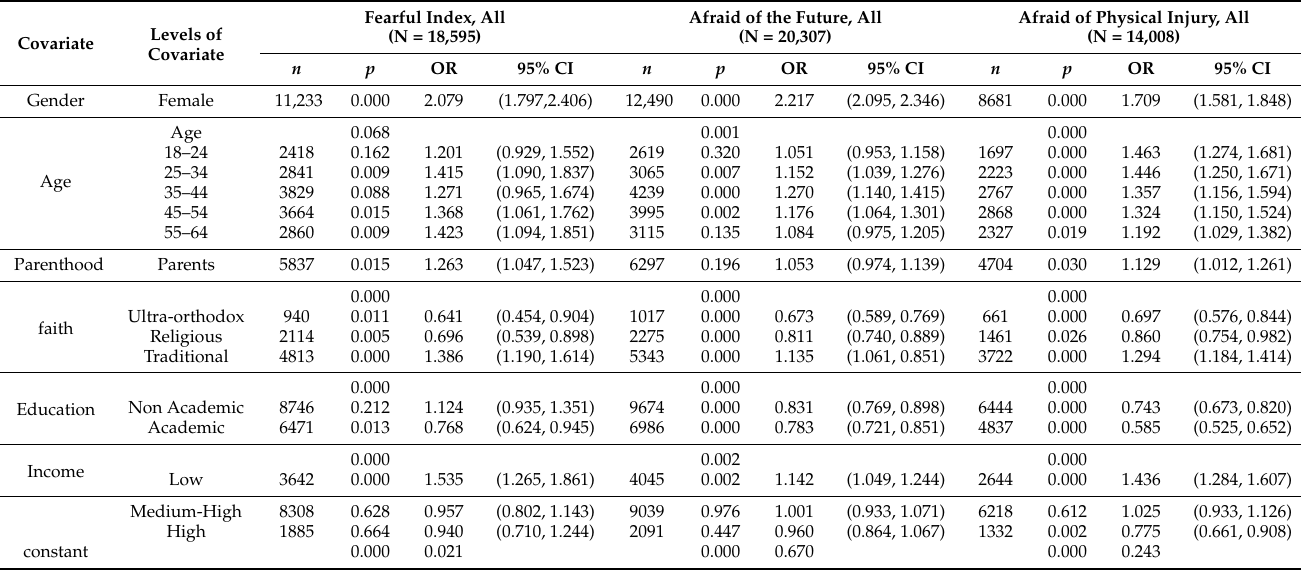
Table 3. Binary logistic model of the three fear measures.